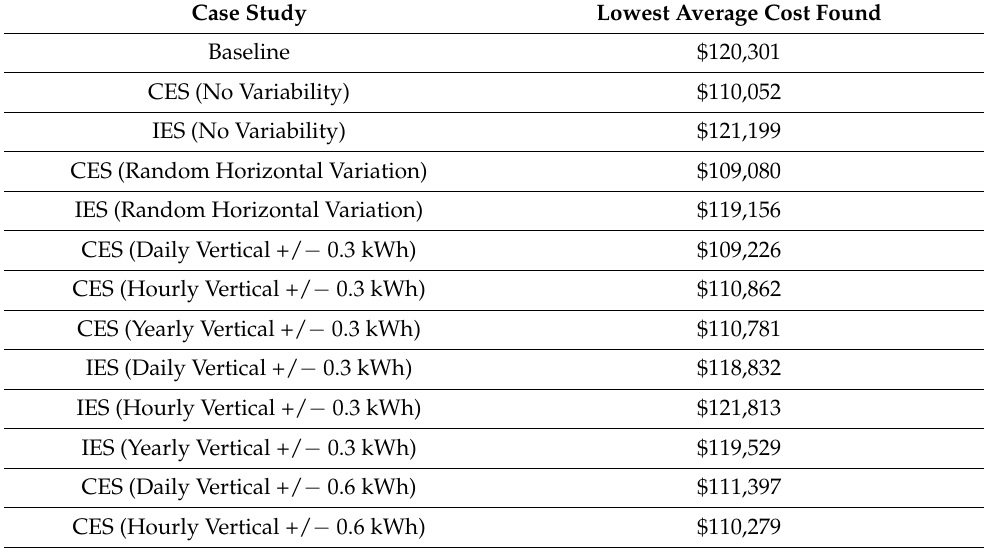
Table 4. Summary of load variability case studies in Indianapolis given 5 systems, starting month of June, 0.1% LPSP required, 100 trials, and 10% initial battery charge.